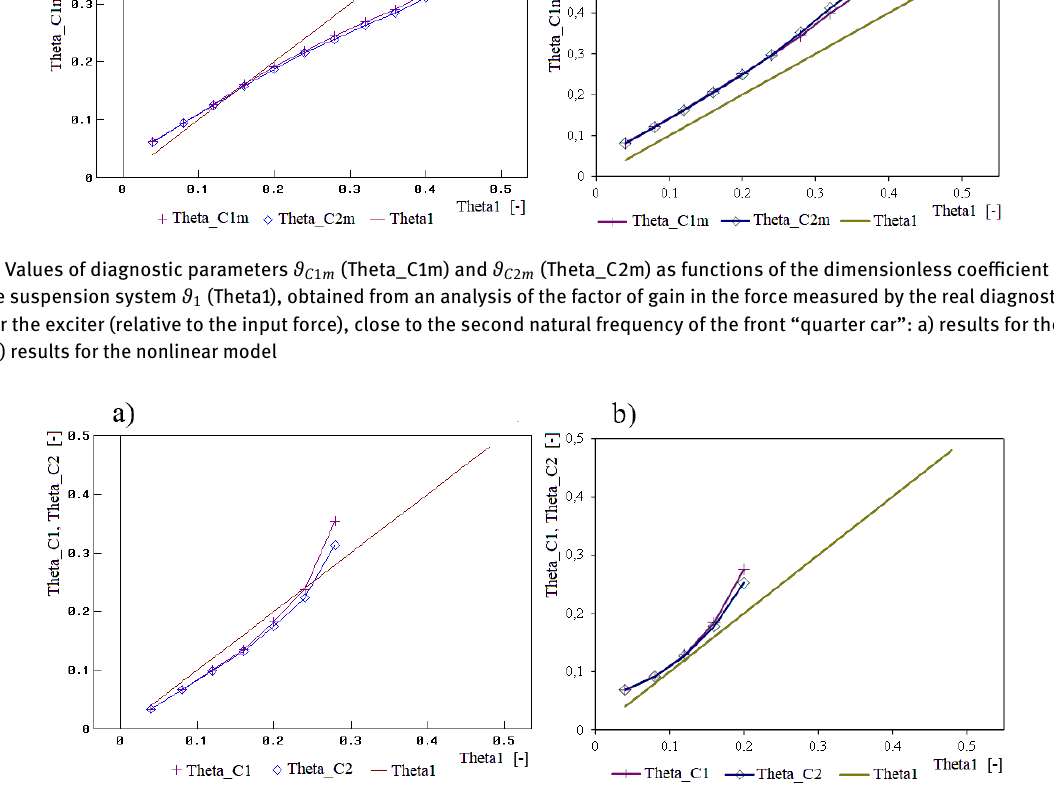
Figure 9: Values of diagnostic parameters ϑ C 1 (Theta_C1) and ϑ C 2 (Theta_C2) as functions of the dimensionless coeflcient of damping in the suspension system ϑ 1 (Theta1), obtained from an analysis of the factor of gain in the vertical force at the tire-exciter contact point (relative to the input force) close to the first natural frequency of the rear “quarter car”: a) results for the linear model; b) results for the nonlinear